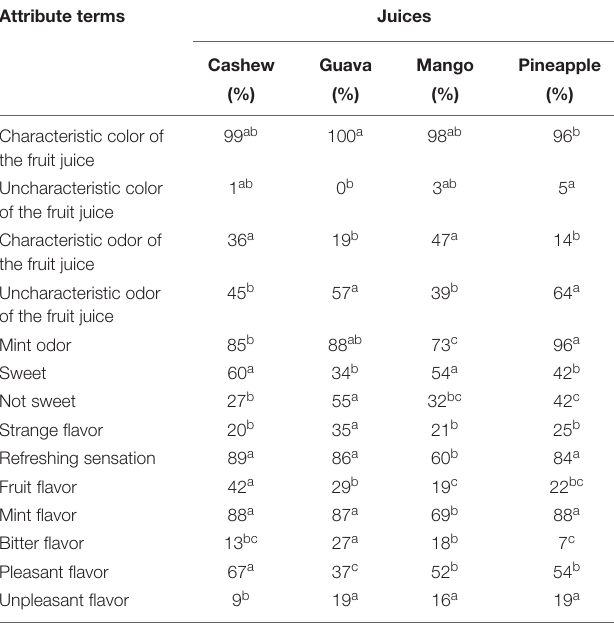
TABLE 3 | Attribute terms percentage of the check-all-that-apply (CATA) questions of cashew, guava, mango, and pineapple juices with Mentha spicata L. essential oil (1.875 µ